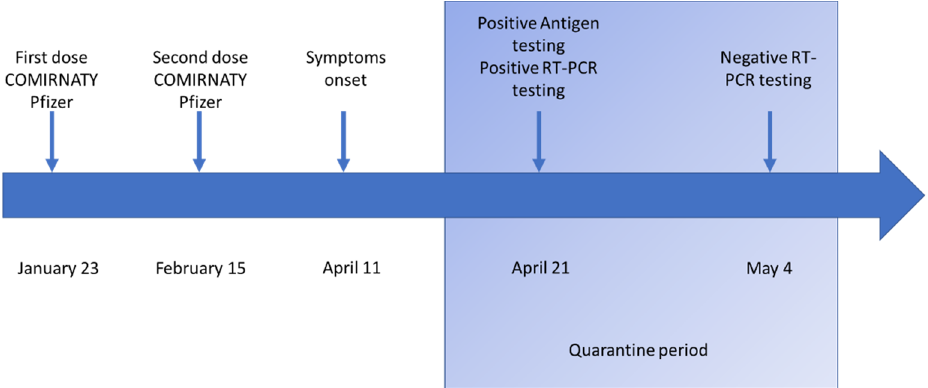
Figure 1. Timeline of events during vaccinations and infection.